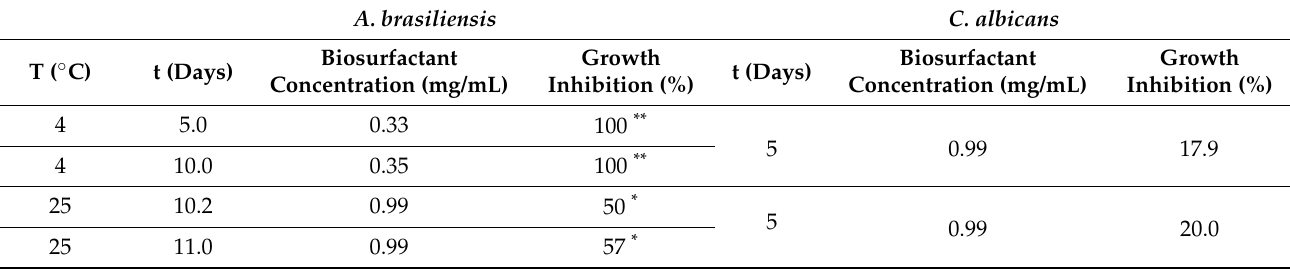
Table 4. Fungicidal and fungistatic conditions of the biosurfactant extracted from the CSW against A. brasiliensis and C. albicans in refrigerator storage (4 ◦ C) and room temperature (25 ◦ C) (* fungistatic effect, ** fungicidal